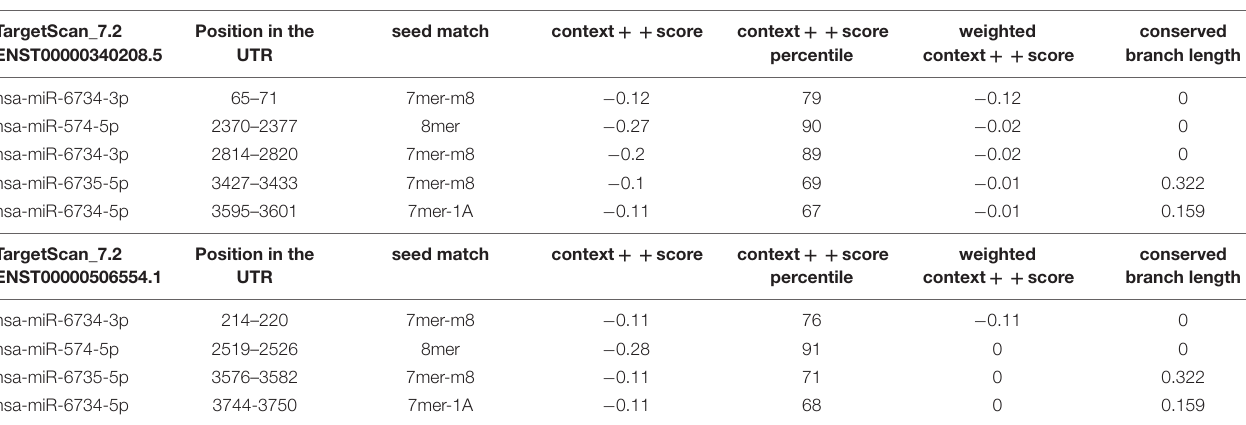
TABLE 8 | The MEF2C-miRNA interactions, binding sites and scores as per Targetscan tools. TargetScan_7.2